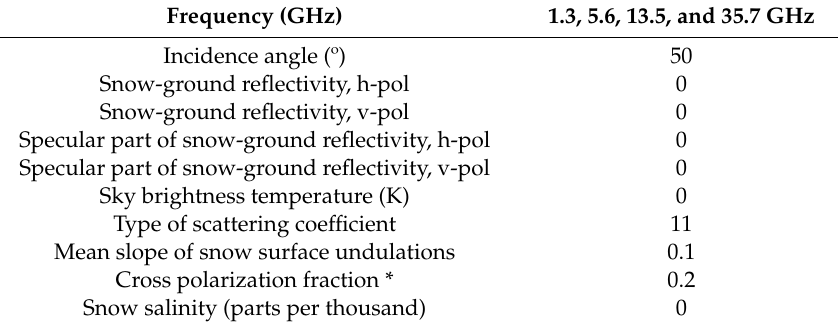
Table 2. Parameters set for active and passive microwave remote sensing of snow in MEMLS. The scattering coe ffi cient refers to the specific parameterization of the 6-flux scattering coe ffi cients, and 11 was proved to be the best [35]. * Parameter estimated from Sentinel-1 5.6 GHz